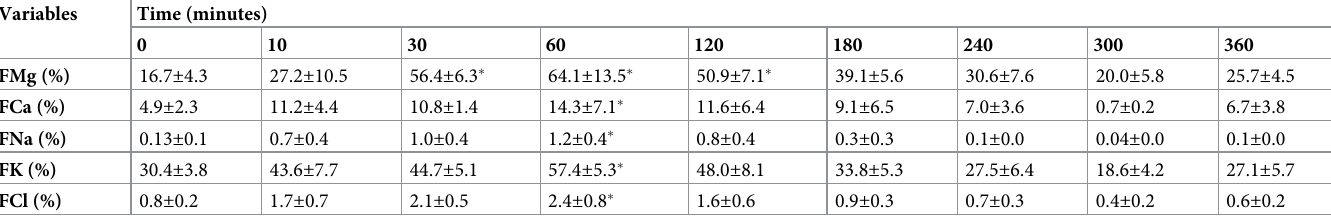
Table 3. Urinary fractional excretion of Mg 2+ , Ca 2+ , Na + , K + , and Cl - following IV administration of MgSO 4 (60 mg/kg, IV) in healthy horses.